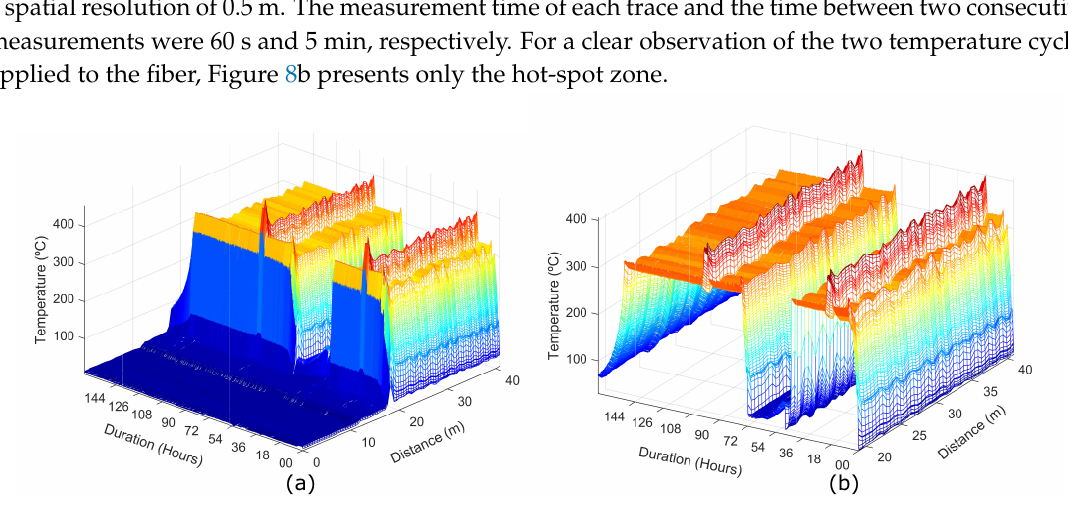
Figure 8. Temperature distributed measurements; ( a ) Entire FUT; ( b ) Hot-spot